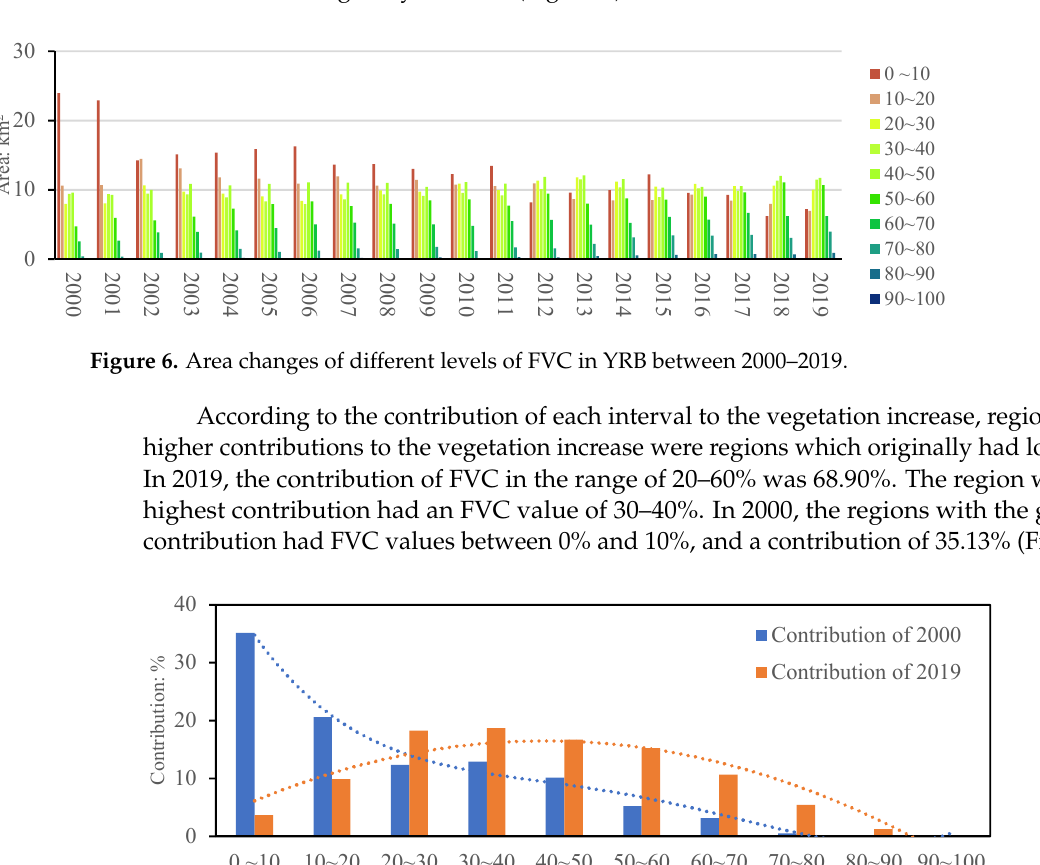
Figure 7. Contribution of different grades of FVC in YRB of 2000 and 2019. From the statistical results of the vegetation types, grassland has an advantage in terms of its proportional area and contribution to the vegetation increase in the YRB; its FVC value was concentrated in the range of 0–60% (Figure 8c). The grassland area accounts for approximately 41.35% of the basin area (Figure 8a), and the contribution to the basin vegetation was as high as 44.67% (Figure 8b). The annual growth rate was 0.58%. The second largest contributor was cropland. The proportion of cropland area in the YRB was 19.40%, which is higher than the national average in the Remote Sensing Survey and Assessment of National Decade Change of Ecological Environment (2000–2010) [49]. The FVC was concentrated between 20–50% (Figure 8c), which was higher than the average grassland value. The annual growth rate was the fastest at 0.76% and its contribution was 32.23% (Figure 8b). The FVC of shrubs was mainly distributed between 30–80%, and the forest was mainly distributed between 50–90% (Figure 8c). The contributions of shrubs and forests were 14.73% and 8.36%, respectively (Figure 8b). In summary, the contribution of grassland and cropland to the increase in FVC in the YRB was high and was mainly located in low FVC areas. Grassland and cropland have advantages in terms of their vegetation type, and their FVC is mostly less than 60%. Forest and shrub FVCs were mostly higher than 70%. The area distribution of the four vegetation types was relatively uniform and in the range of 60–70%